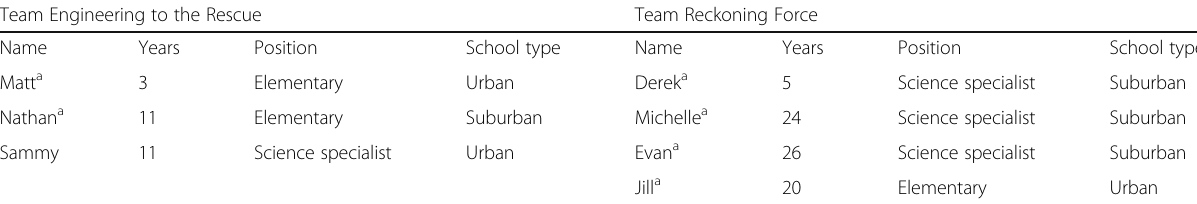
Table 1 Team participants and demographic information Team Engineering to the Rescue